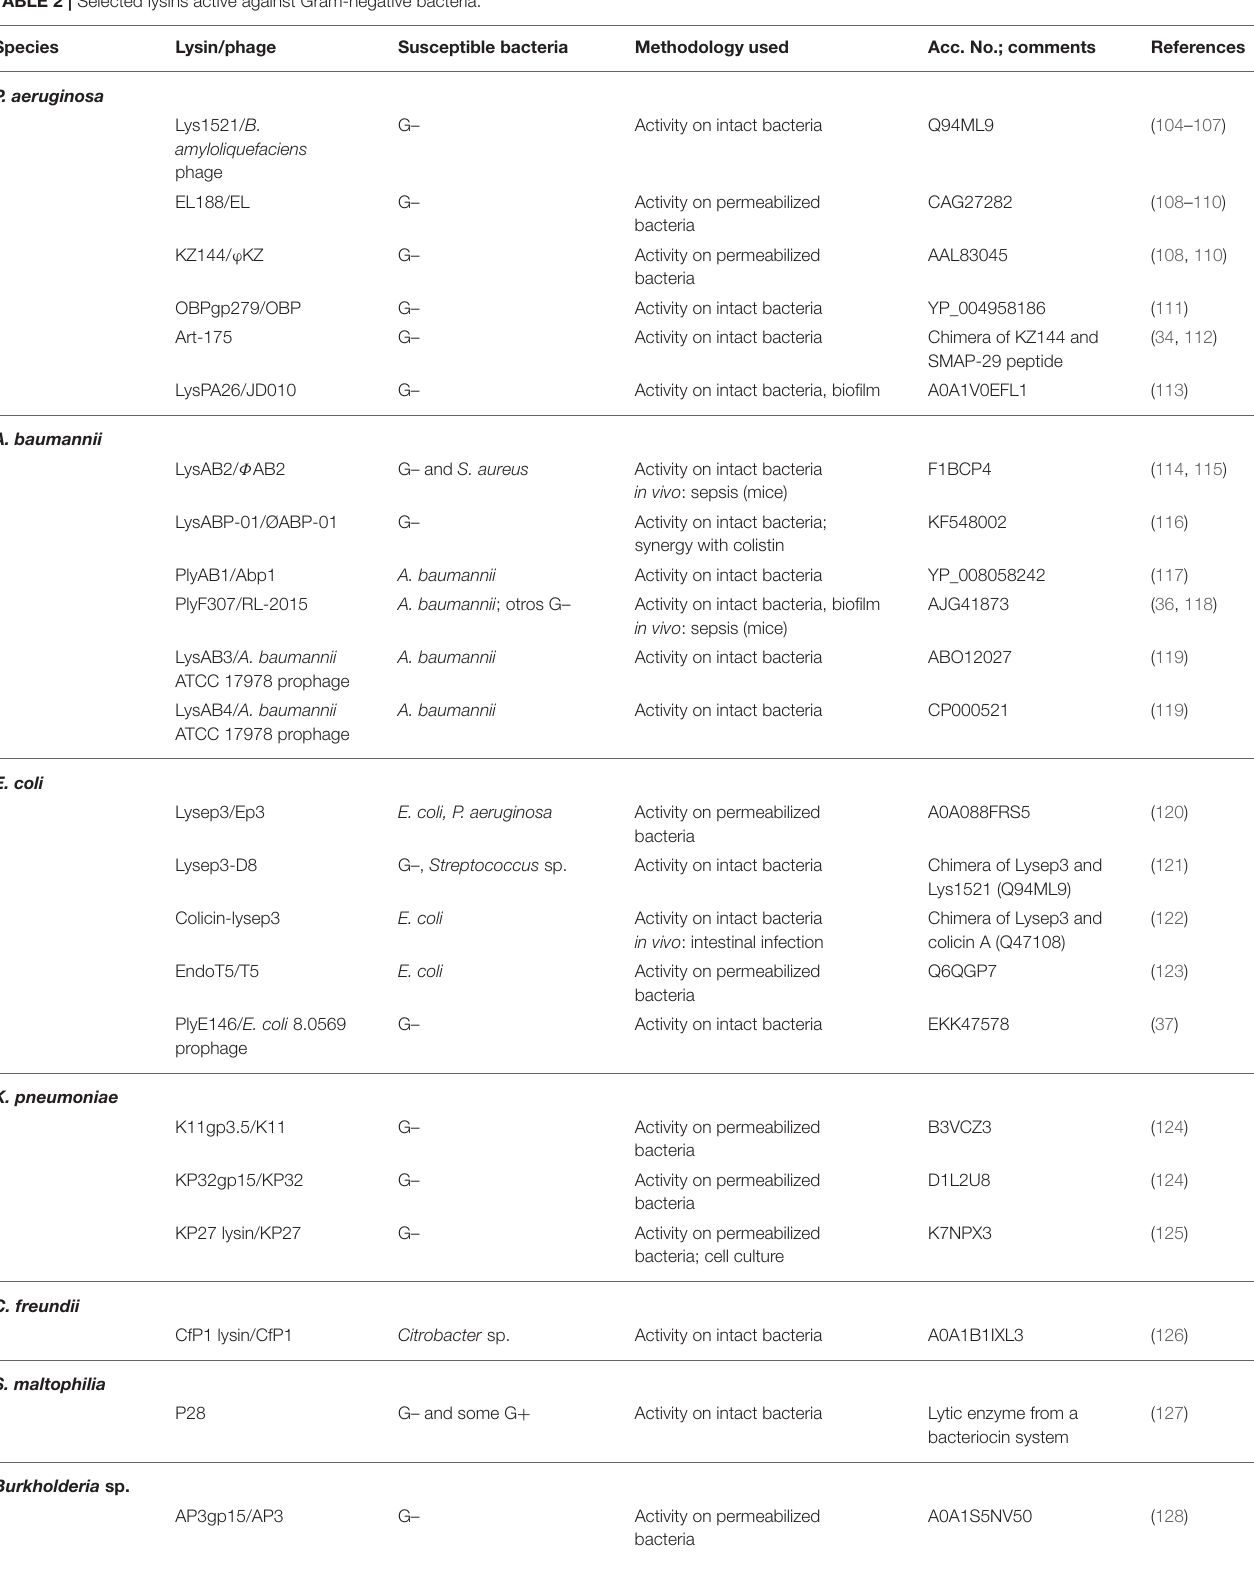
TABLE 2 | Selected lysins active against Gram-negative